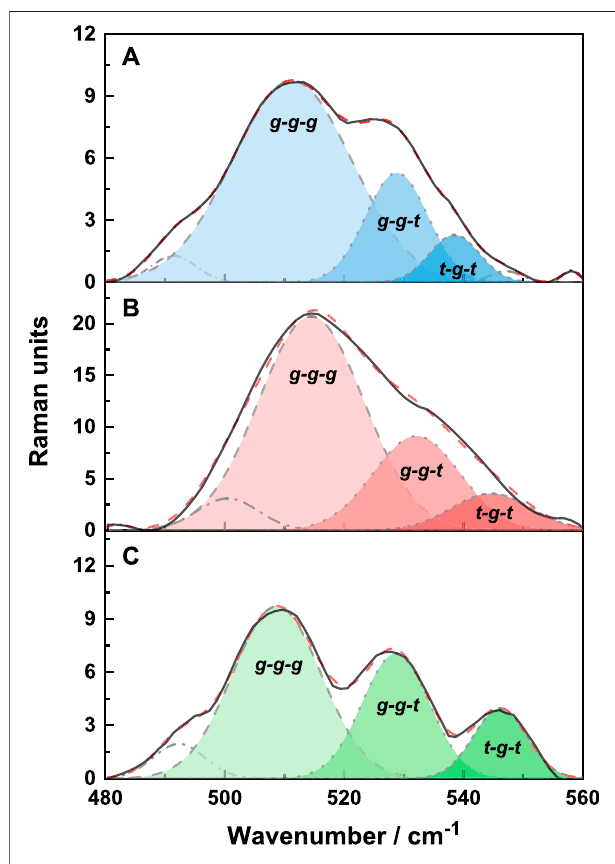
FIGURE6| ThedeconvolutionoftheS-SregionoftheRamanspectraof natural wool (A) , K-C (B) , and K-M (C) .